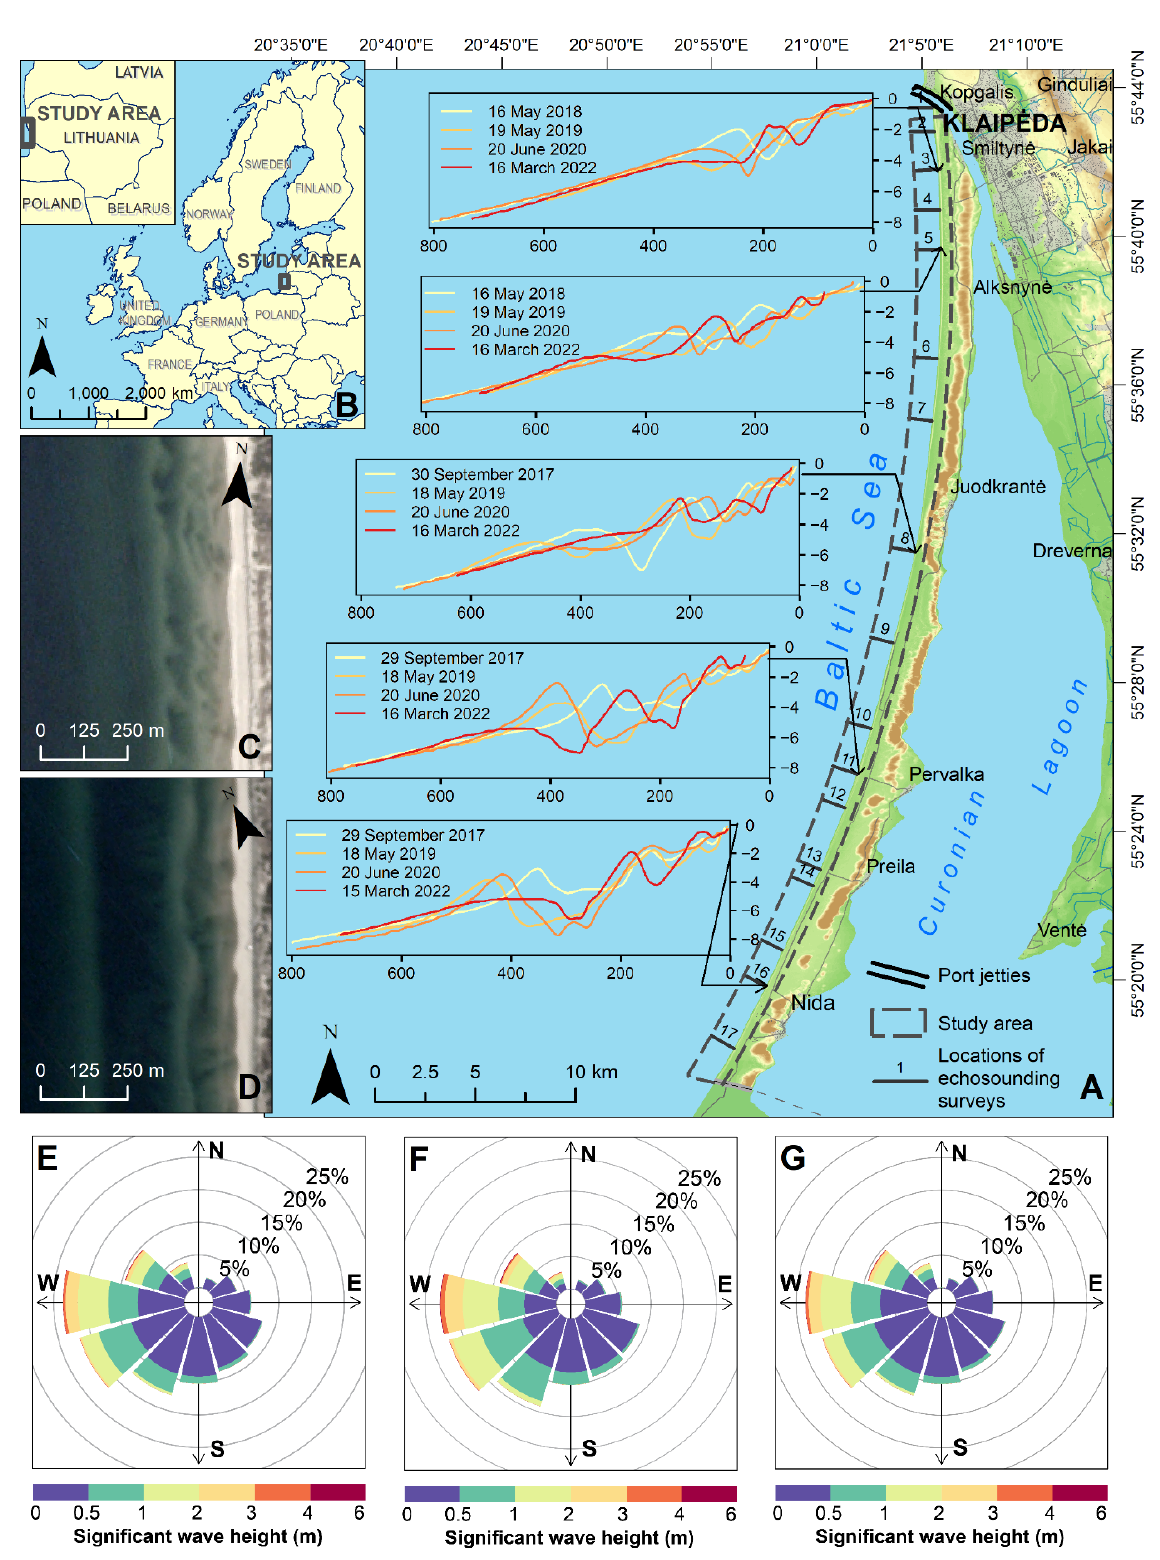
Figure 1. Configuration ( A ) and location ( B ) of the Curonian Spit (adapted from Janušaitė et al. [2,39]). Panels ( C , D) contain PlanetScope images showing the typical bar morphologies at Smiltynė ( C ) and Nida ( D ). Panels ( E – G) display wave roses of the Curonian Spit in 2011 – 2021, derived from the Copernicus Baltic Sea wave reanalysis data [46] for the entire year ( E ), high- ( F ) and low- ( G ) wave-energy seasons.